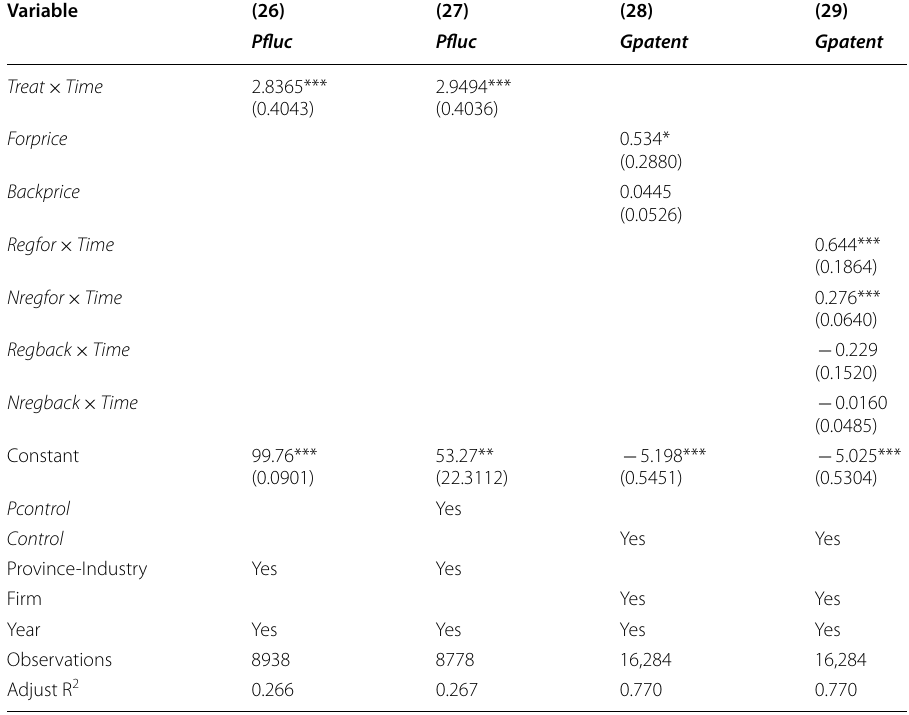
Table 8 Transmission mechanism test